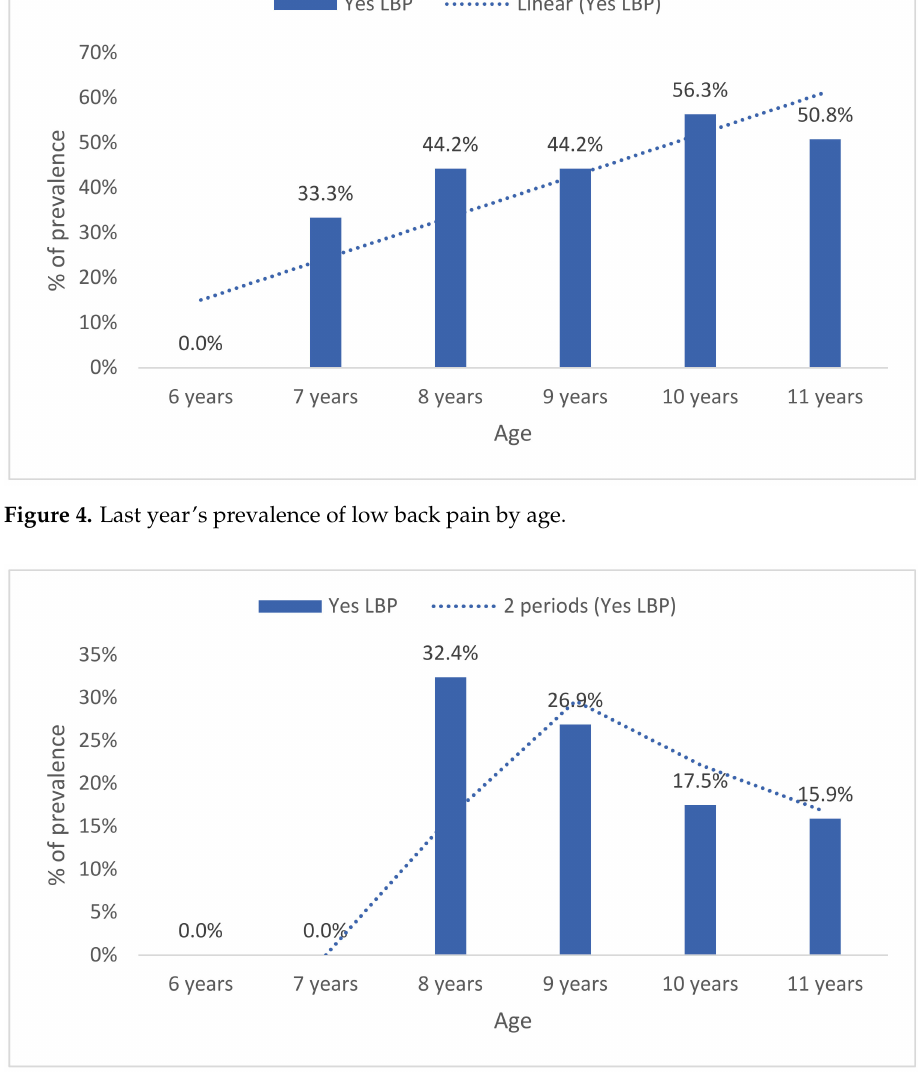
Figure 5. Last week’s prevalence of low back pain by